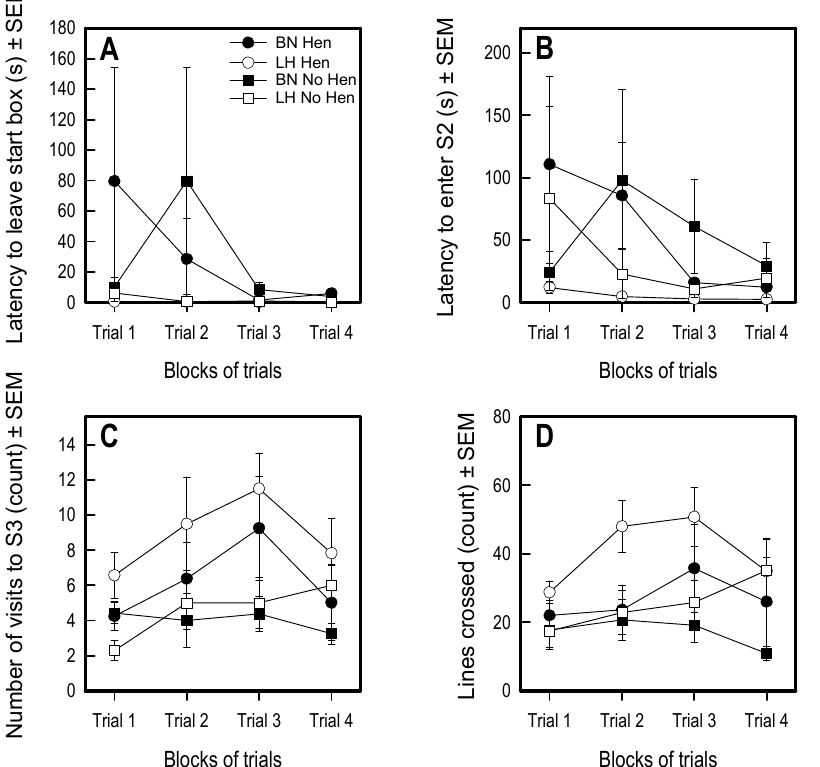
Figure 4. Results of the social vs. foraging test for the parameters ( A ) latency to leave start box, ( B ) latency to enter S2, ( C ) number of visits to S3, and ( D ) lines crossed. Significant main effects of line were found on latency to leave start box and latency to enter S2. Significant main effects of hen rearing were found on visits to S3 and lines crossed. Lines represent averages and SEM.